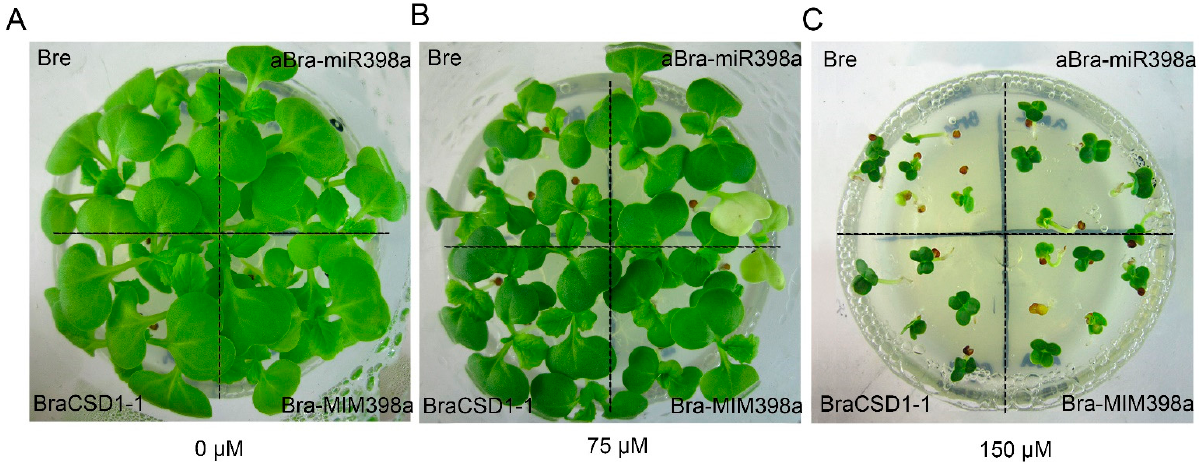
Figure 5. The phenotype of transgenic plants treated with Cu 2+ . The seedlings of the transgenic plants growing on MS medium containing 0 µM ( A ), 75 µM ( B ), and 150 µM ( C ) Cu 2+ , respectively.